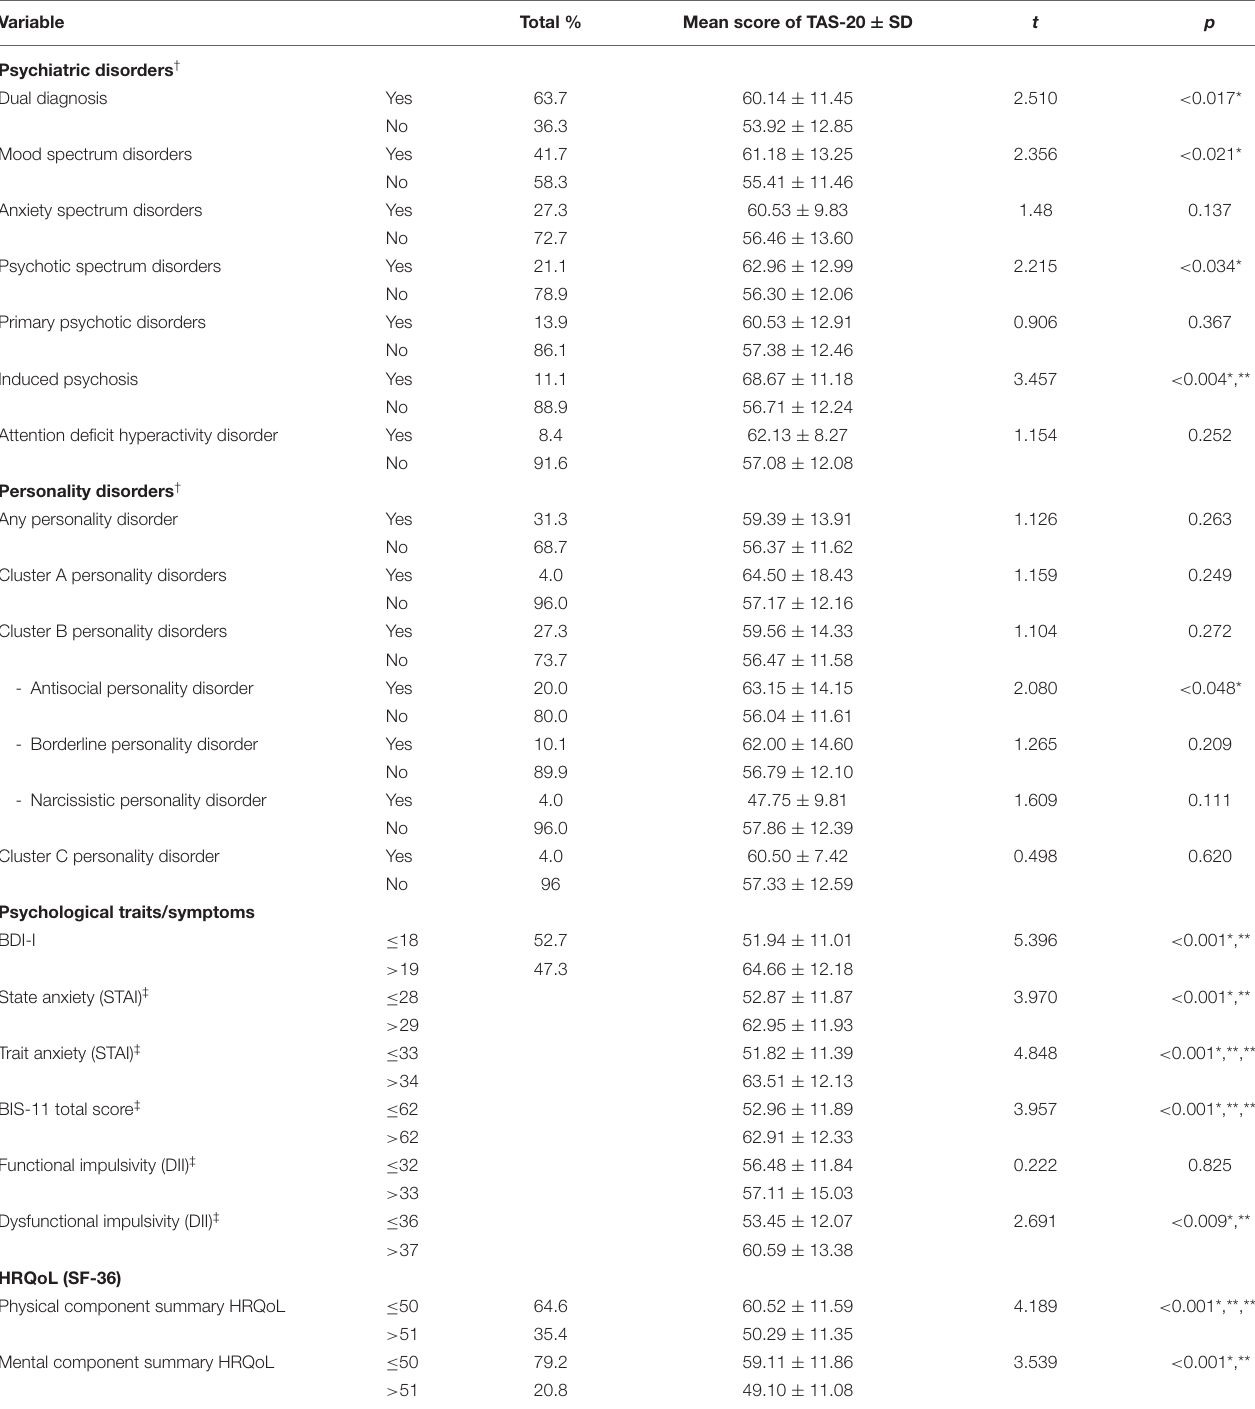
TABLE 3 | Current psychiatric comorbidity and psychological symptoms of patients, analyzed by alexithymia levels.